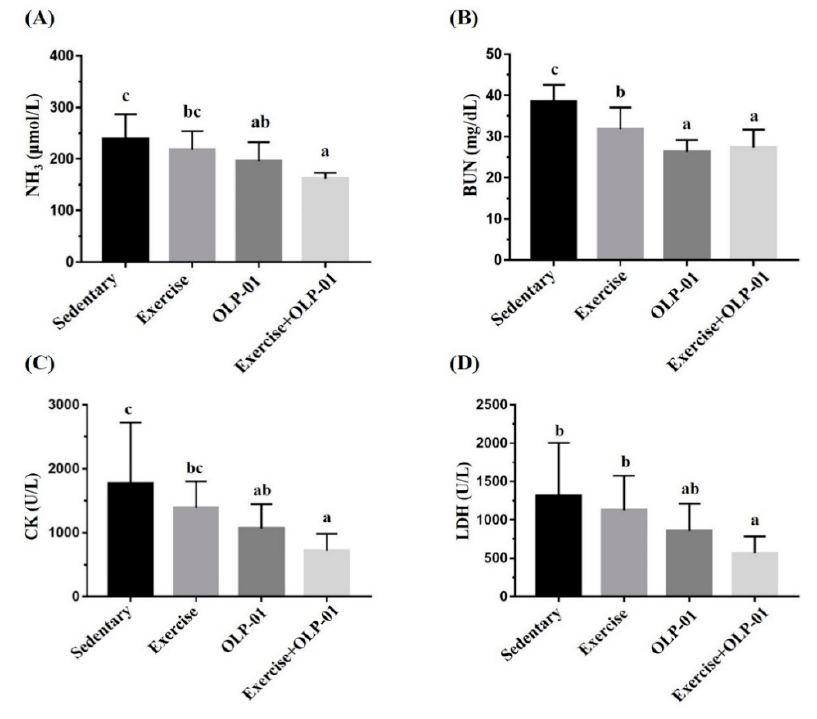
Figure 5. Effects of six weeks of exercise and probiotic interventions on ammonia ( A ), blood urea nitrogen (BUN) ( B ), CK ( C ), and LDH ( D ) levels after acute and prolonged exercise challenges. Data are represented as the mean ± SD, and columns with different letters (a, b, c) were significantly different at p < 0.05.